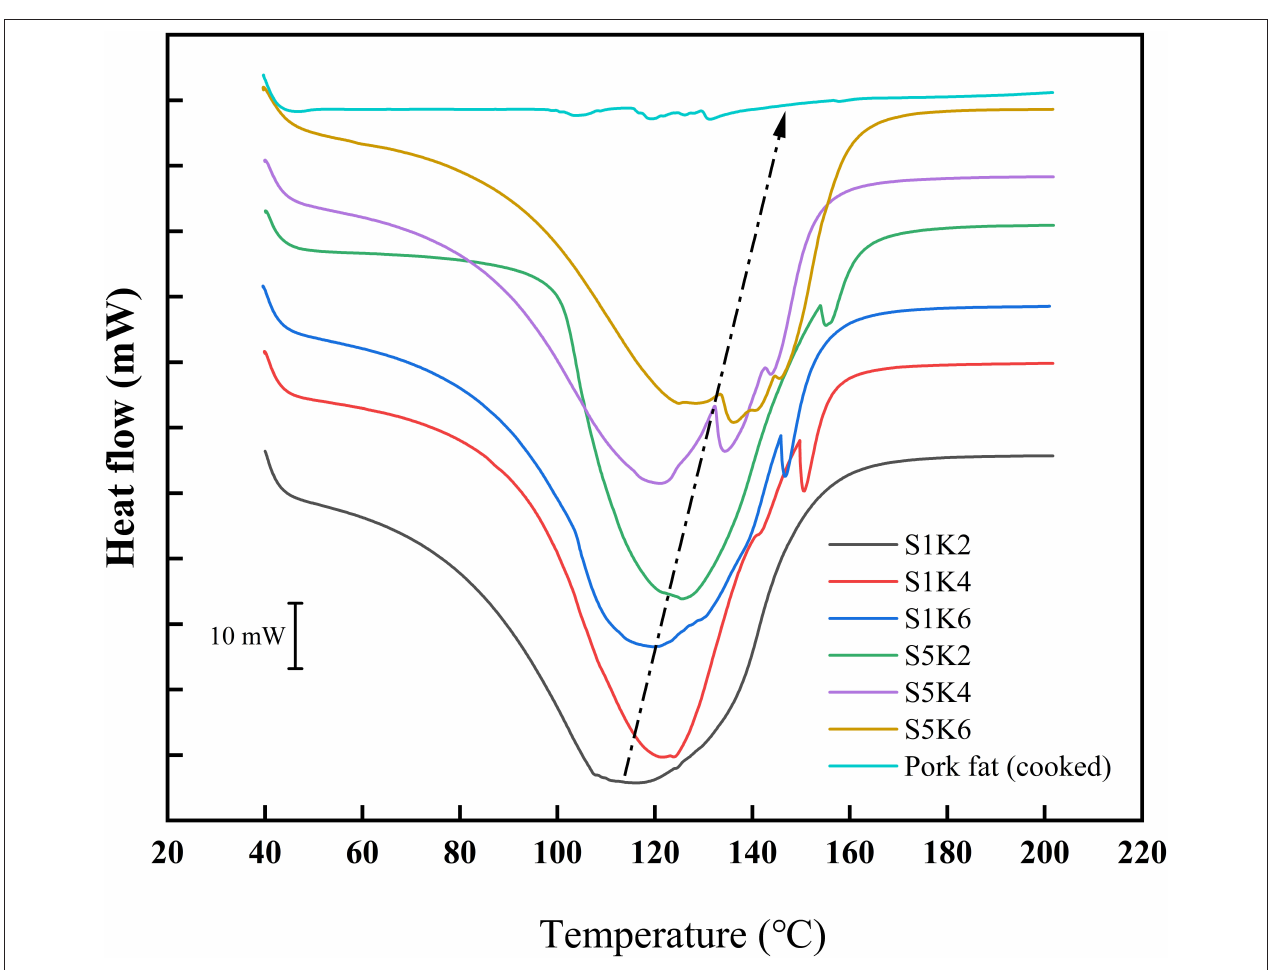
FIGURE 5 | DSC curves of samples with different protein content and konjac content and pork fat (cook for